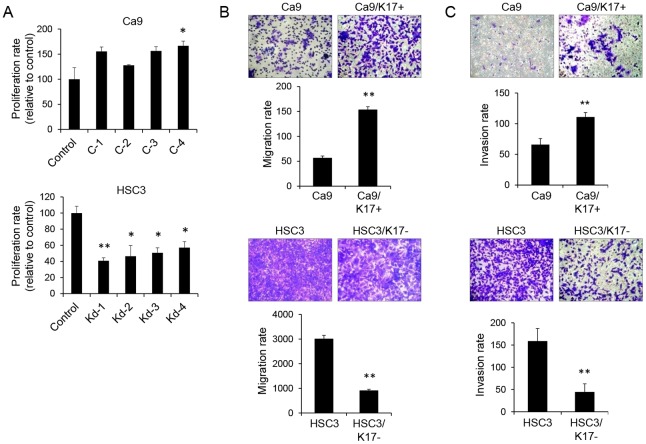
KRT17 promoted cell proliferation and migration.(A) Cell proliferation assay after 72h of culture. C-4 showed a significantly higher rate of proliferation than the control. *P < 0.05 compared with the control. C-1, C-2, and C-3 showed a tendency towards elevated proliferation (0.05 < P < 0.1). HSC3/K17- showed significantly lower rates of proliferation than the control. Representative graphs of n = 3 independent experiments (each experiments comprised three technical replicates). **P < 0.01 and *P < 0.05 compared with the control. Data represent mean ± SEM. (B) Transwell migration assay using Boyden chambers. Cells (2 x 105 cells/L) were suspended in serum-free medium and seeded into the upper chamber with pores of 8 μm. The lower chamber was filled with serum-containing medium. The upper chamber was confluent with cells during the assay. After 48 h, the cells that had migrated into the lower chamber through the filter were stained with crystal violet and counted in three microscopic fields per sample. Representative graphs of n = 3 independent experiments (each experiments comprised three technical replicates). **P < 0.01 compared with the control. Data represent mean ± SEM. (C) Transwell invasion assay. The filters were coated with an extracellular matrix protein mixture, and a transwell migration assay was conducted. Representative graphs of n = 3 independent experiments (each experiment comprised three technical replicates). **P < 0.01 compared with the control. Data represent mean ± SEM.